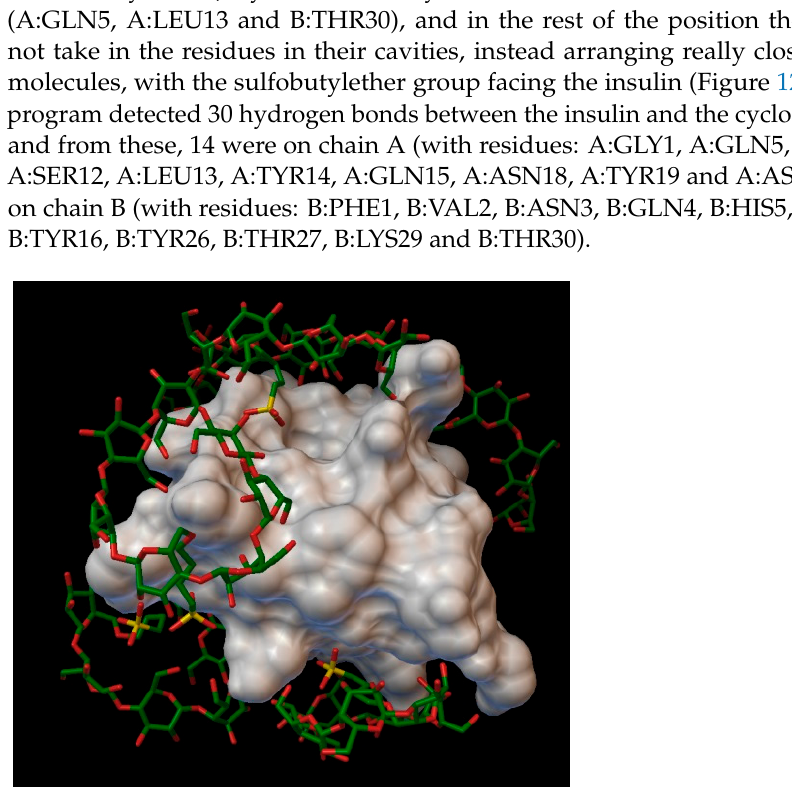
Figure 12. Insulin-sulfobutylether- β -cyclodextrin (DS 1) complex. The insulin molecular surface is marked with white and the cyclodextrin molecules are marked with green and red licorice.